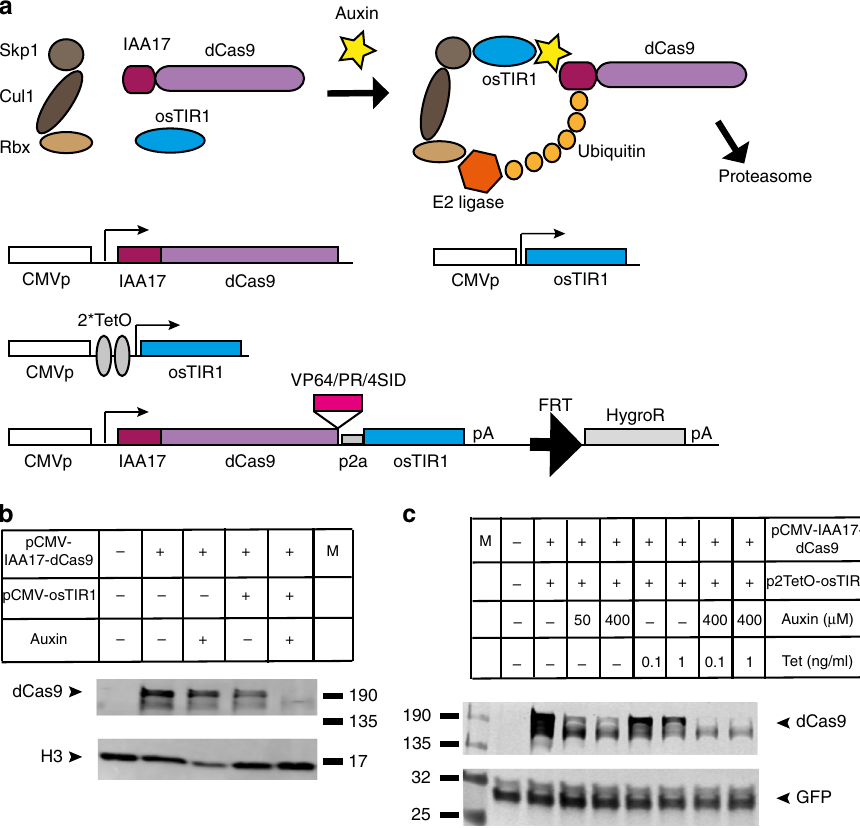
Fig. 1 Small molecule inducible degradation control of dCas9 using the Auxin inducible degron. a Schematic overview of the AID-dCas9 system. The IAA17 peptide, which confers sensitivity to degradation upon addition of the plant hormone auxin, is fused to the N-terminus of dCas9. The cullin/skp/rbx components are present in mammalian cells, but auxiliary protein TIR1 has to be externally supplied. Upon addition of auxin a complex is formed with E2 ligase, resulting in poly-ubiquination and proteasomal degradation. IAA17-dCas9 and osTIR1 can be expressed from separate plasmids, allowing independent tetracyclin-inducible control of osTIR1 expression, or from a single combined construct suitable for Flp-mediated integration into FRT containing genomic insertion platforms. Effector domains of interest (e.g., VP64) can be fused to the C-terminus of AID-dCas9. b The IAA17 degron tagged dCas9 fusion protein is sensitive to degradation upon addition of auxin only in the presence of osTIR1. Western blot of HEK293FT cells transfected with the constructs shown in the table in the presence or absence of added auxin (400 μ M) and probed with Cas9 antibody. Histone H3 antibody was used as loading control c Placing osTIR1 under control of a Tetracyclin (Tet)-inducible promoter results in degradation of IAA17-dCas9 only in the presence of both auxin and tetracyclin, effectively creating an AND or NAND gate depending on the C-terminal effector domain attached to dCas9. HEK293FT cells were transfected with pCMV-IAA17-dCas9 and pCMV-2TetO-osTIR1 and tetracycline or auxin were added as indicated in the table. A control GFP expression plasmid was co-transfected. Samples were probed on Western blot with Cas9 antibody. GFP antibody was used as loading